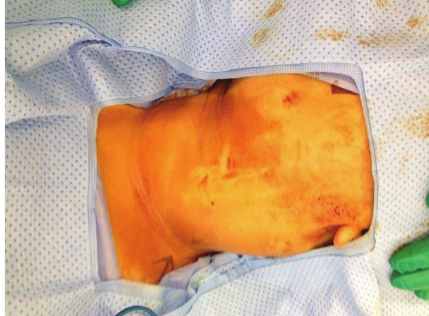
Figure 5: Intraoperative picture showing the mass before starting the skin incision.